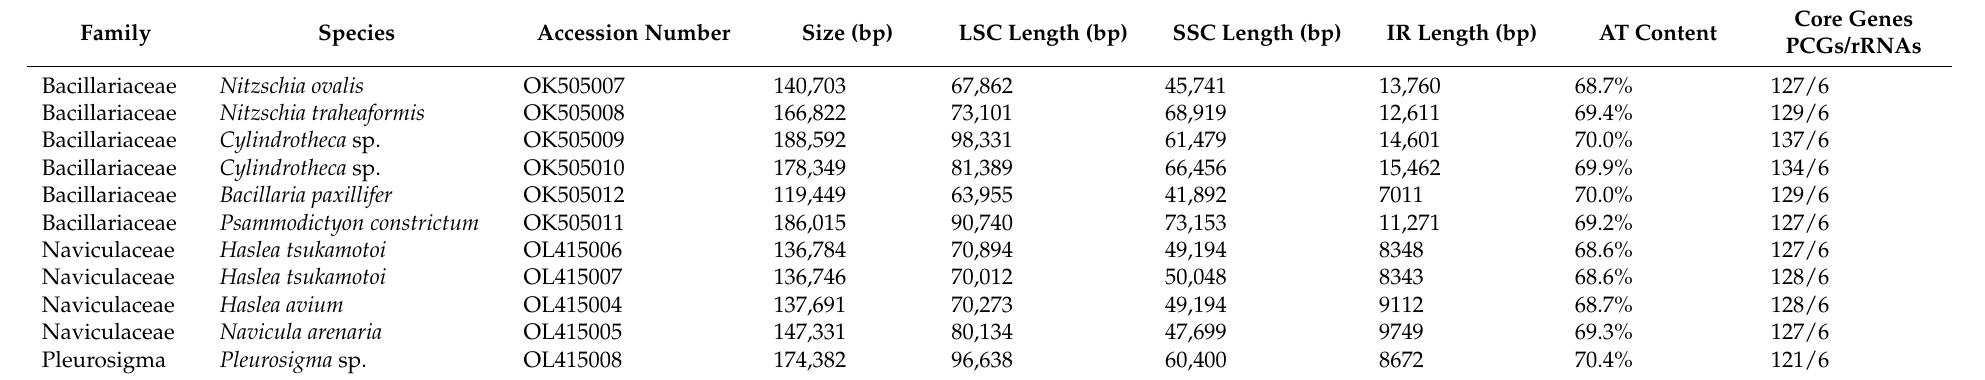
Table 2. Genome features of 11 cpDNAs constructed in this